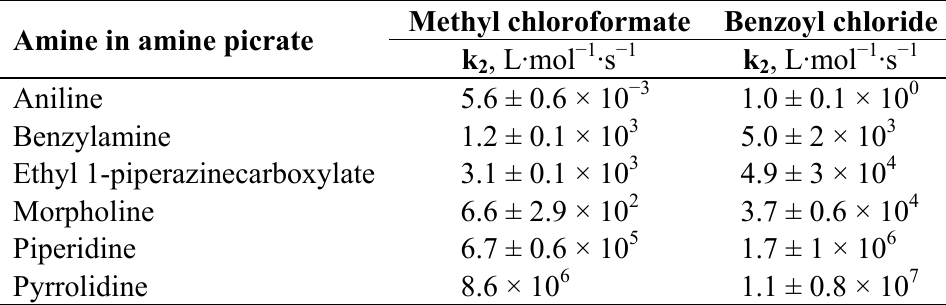
Table 1. Reaction rates of amine picrates with acid chlorides.